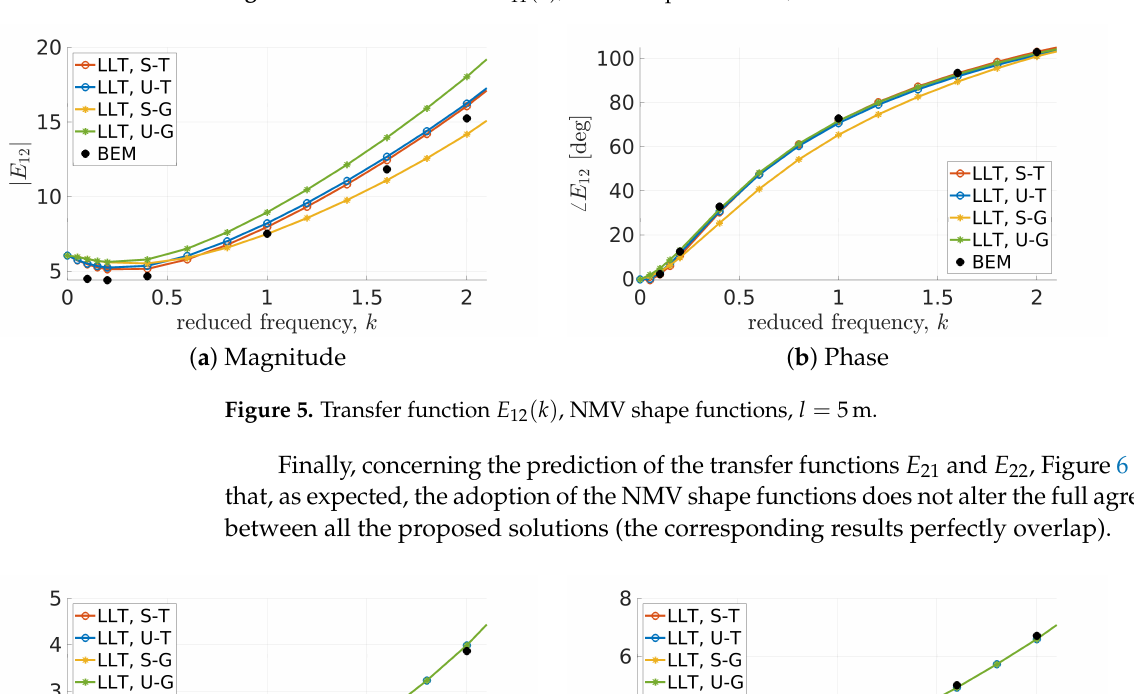
Figure 4. Transfer function E 11 ( k ) , NMV shape functions, l = 5m.